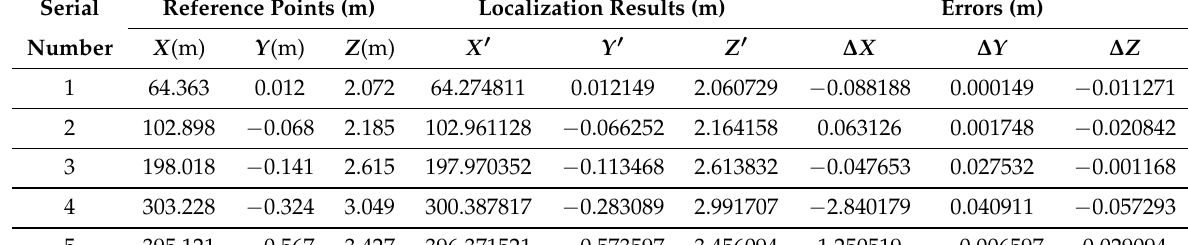
Table 6. The calibration accuracy analysis.